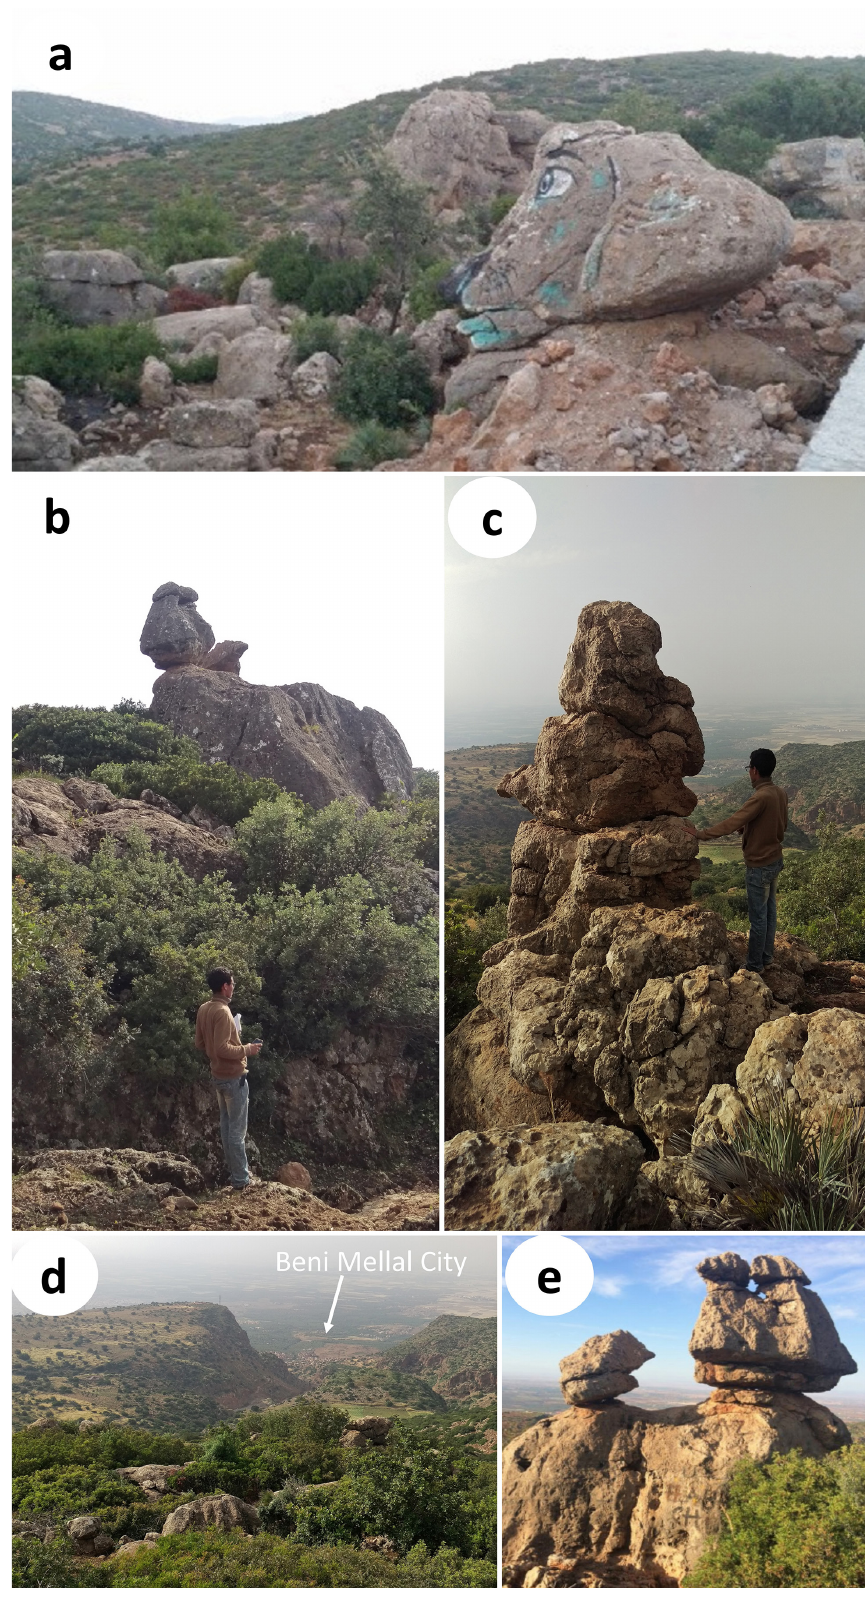
Fig. 9. The ruiniform landscapes of Ain el Ghazi site of varying shapes and sizes. (a), (b), (d), (e) The different shapes of the ruiniform landscapes of the Ain el Ghazi site. (c) Panoramic view of the Ain el Ghazi site and city of Beni